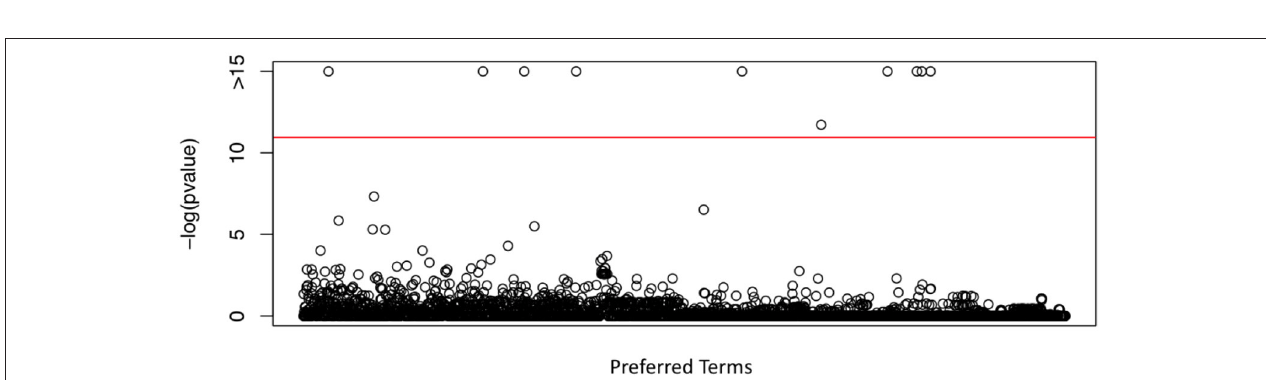
FIGURE 2 | P -values obtained from the proposed test in testing the differential PT rates for HPV vaccination between non-Hispanic White female and other race/ethnicity group, using VAERS data, CDC survey data of HPV vaccination coverage and U.S. census data.